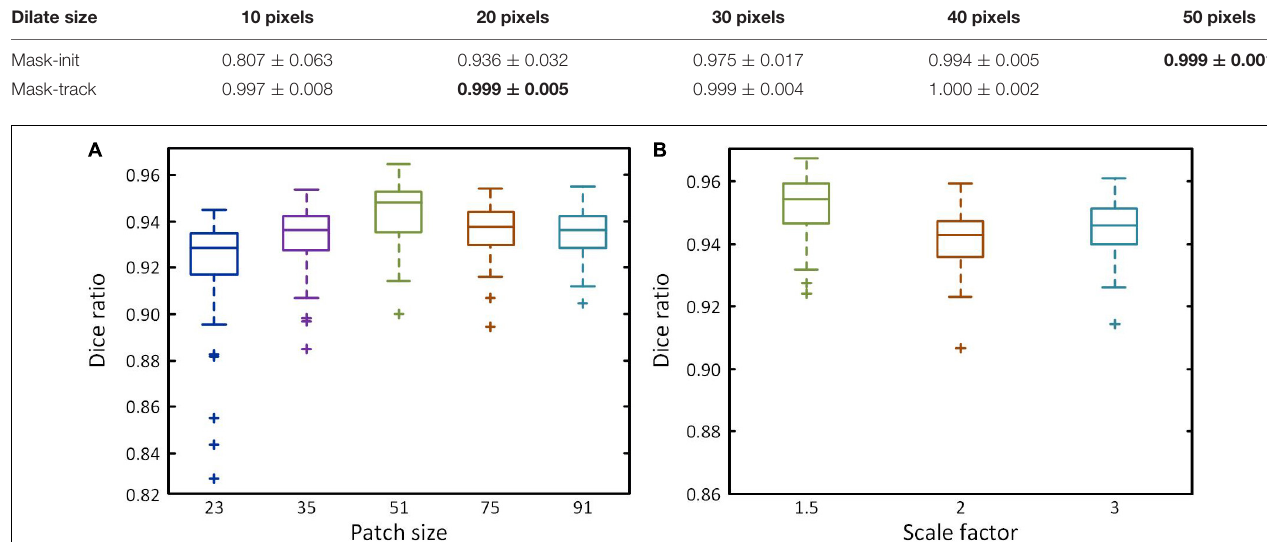
TABLE 1 | Performance of Recall ratio for Mask-init and Mask-track with different dilation size (bold values are the optimal).